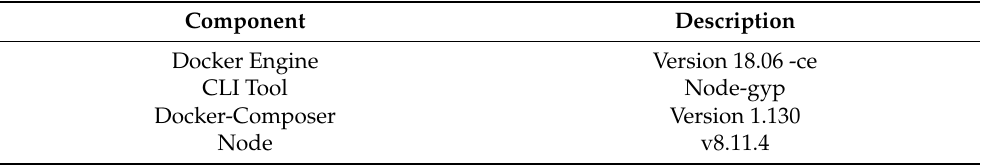
Table 4. Environmental setup of Hyperledger